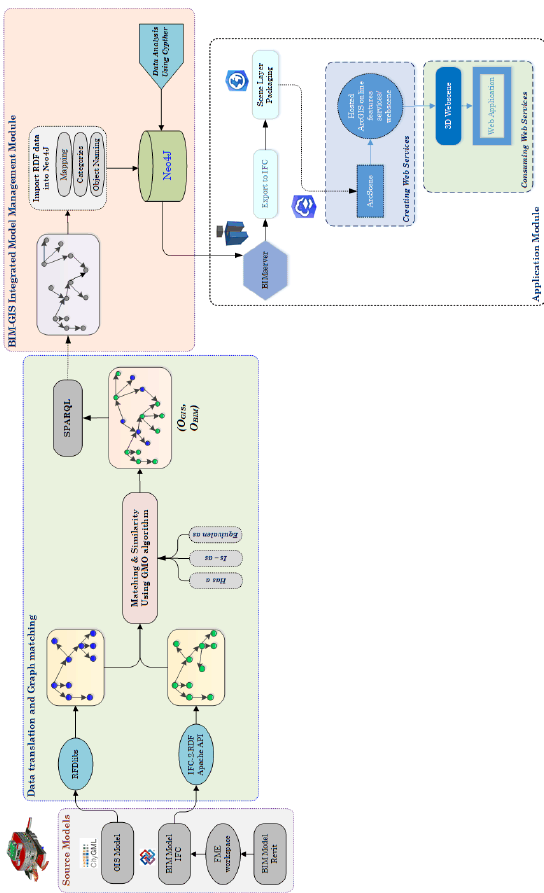
Figure 10. System design